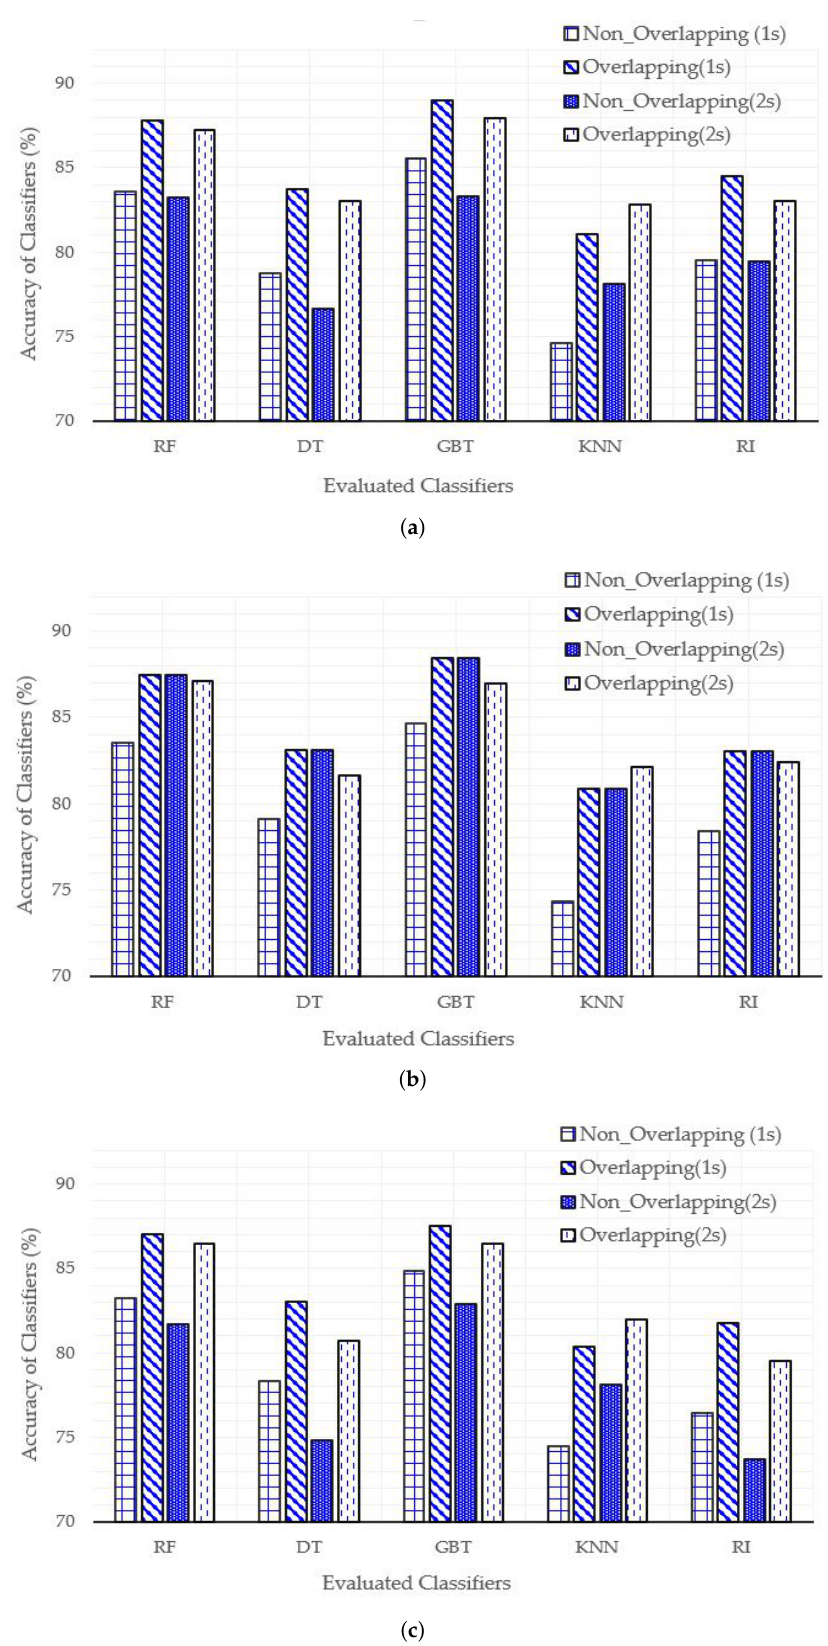
Figure 5. Classifiers performance comparison using various percentages of train–test splits: ( a ) 90–10, ( b ) 80–20, and ( c ) 70–30.